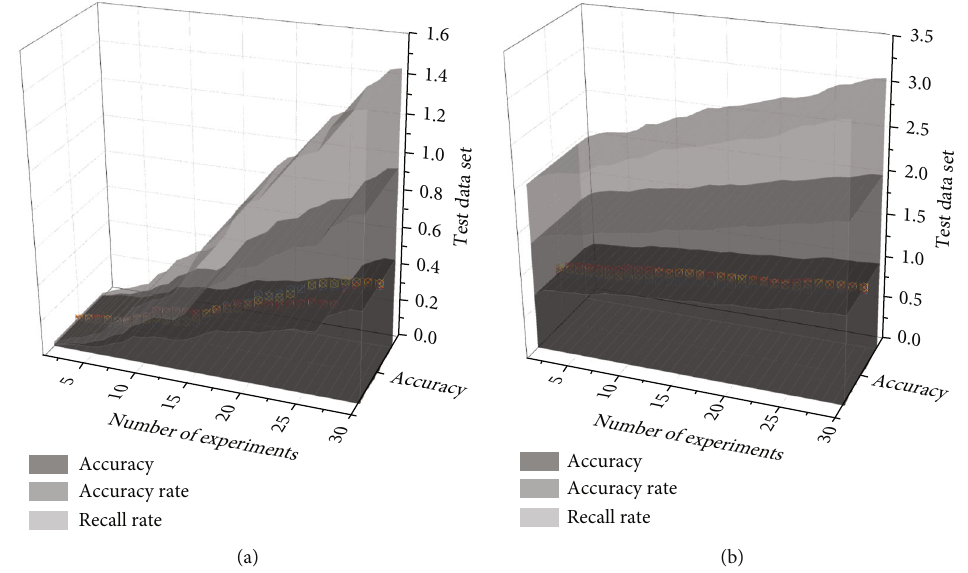
Figure 8: Comparison of rehabilitation treatment techniques before and after data